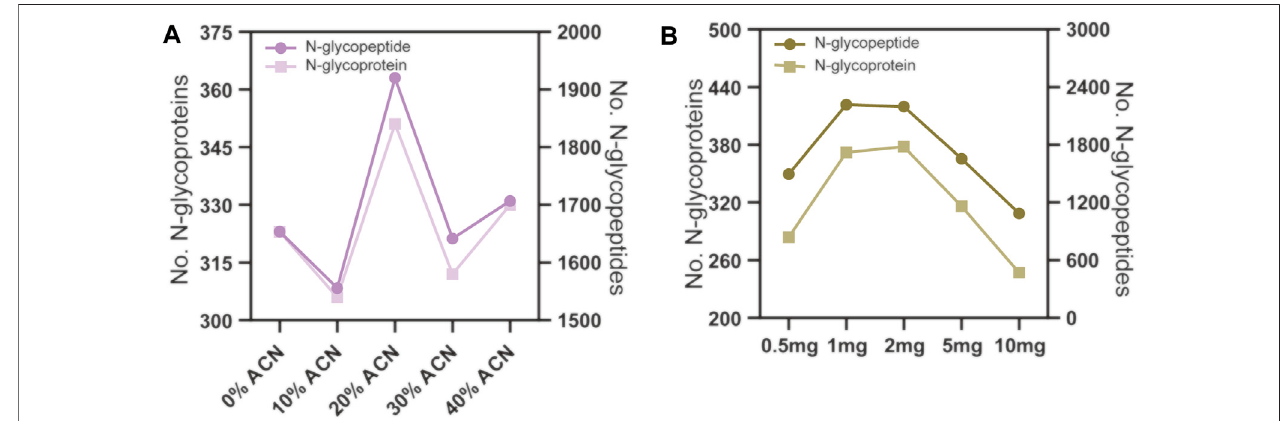
FIGURE2| N-glycopeptideenrichmentfrom160 μ gpeptidesamplesusingdifferentconditions. (A) theACNvolumeratiointheelutingbufferwere0%,10%,20% 30% and 40%. (B) the amount of ZIC-HILIC microparticles were 0.5, 1, 2, 5 and 10 mg.